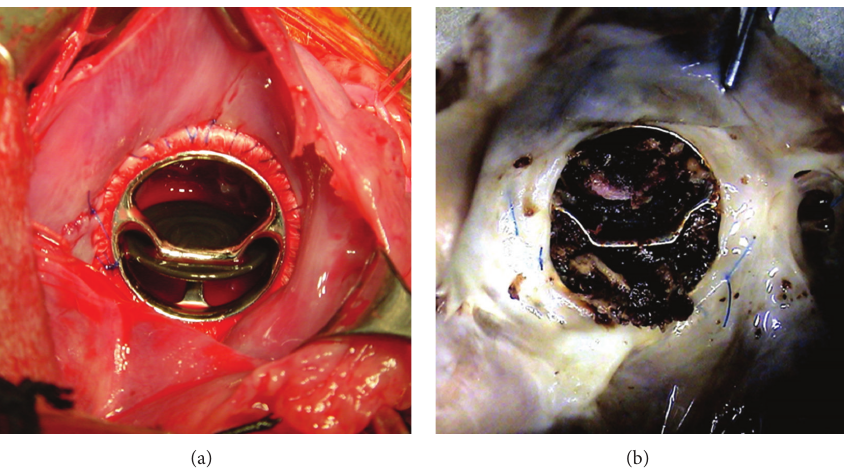
Figure 2: (a) An intraoperative photograph shows Bjork-Shiley oblique valve for aortic valve attached conversely at the mitral valve position. (b) An autopsy photograph (surgeon view) shows the artificial valve covered with a great amount of